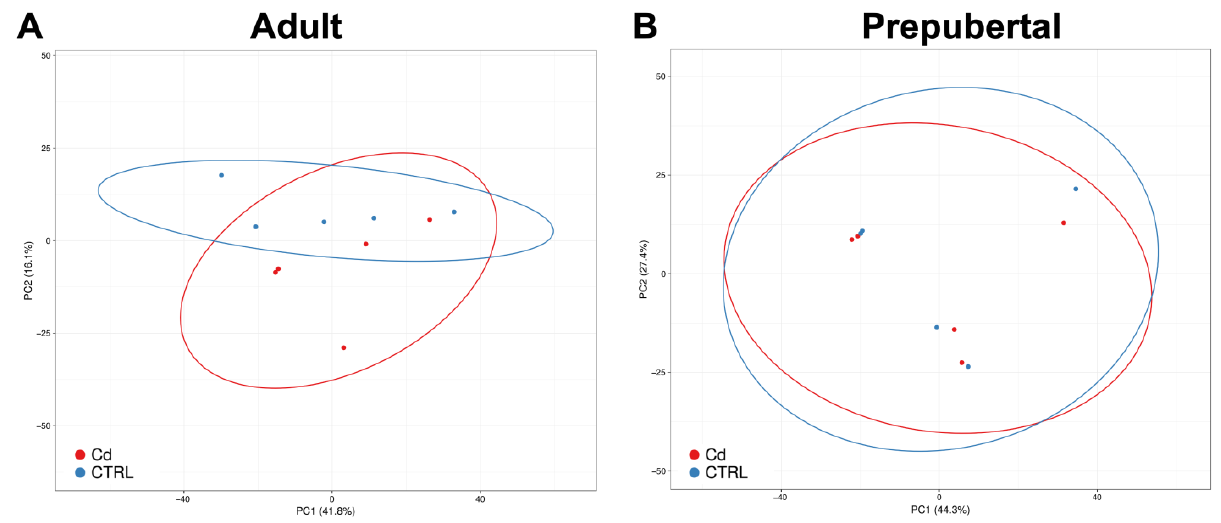
Figure 1. PCA of Cd-treated CCs compared with controls in adult sheep ( A ) and prepubertal lambs ( B ). Red and blue dots indicate Cd-treated and control CC samples, respectively. In adult CC samples, Cd-induced transcriptome separation along the x-axis can be seen ( A ). Instead, in CCs from prepubertal samples, the gene expression pattern is overlapping ( B ). 3.3. Cadmium Induces Higher Number of DEGs in CCs from Adult versus Prepubertal Sheep From CCs isolated from matured oocytes of adult sheep, on average, 23.5 million pairs of stranded reads per sample were obtained. About 83% of these reads were uniquely aligned to the reference genome (Ovis_aries.Oar_V3.1) and assigned to known mRNA transcripts. A total of 17,606 gene loci out of 20,028 Ensembl annotations were found expressed in CCs cells. By using unique and concordant RNA-seq reads, ninety- nine genes appeared differentially expressed (DEG) upon Cd exposure and are shown in the heatmap of Figure 2. Of these, 73 genes were upregulated (Table S1) whereas 26 genes were downregulated (Table S2) after in vitro exposure to Cd.